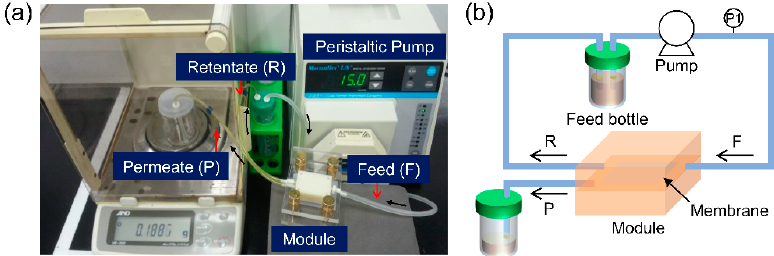
Figure 1. ( a ) Photographic image and ( b ) schematic drawing of the cross-flow filtration system used in this